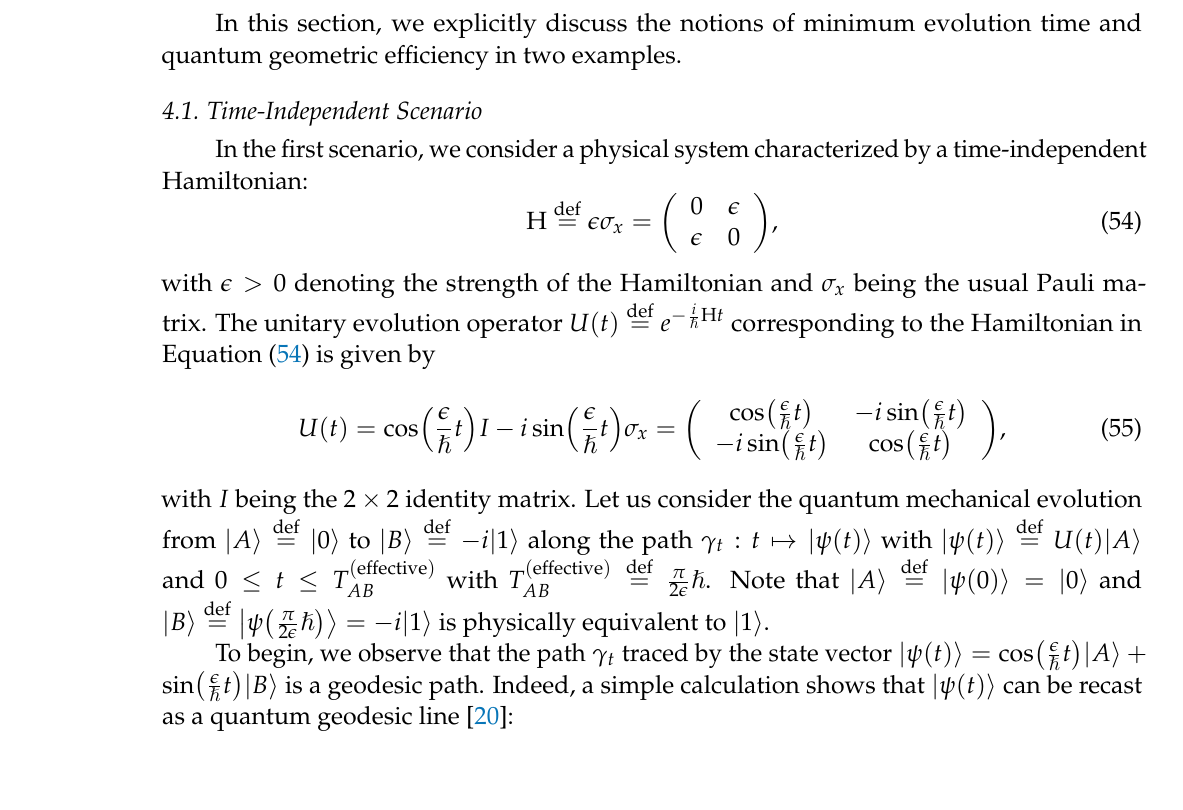
Table 1. Schematic description of the optimal quantum evolution conditions for motion between either two orthogonal or nonorthogonal states. In both scenarios, the energy dispersion ∆ E 2 of the Hamiltonian operator H is assumed to be constant in time. Unit geometric quantum efficiency motion with η def = η inequality relation becomes an equality constraint. Quantum States Time-Energy Inequality Constraint Optimal Quantum Evolution Condition Orthogonal